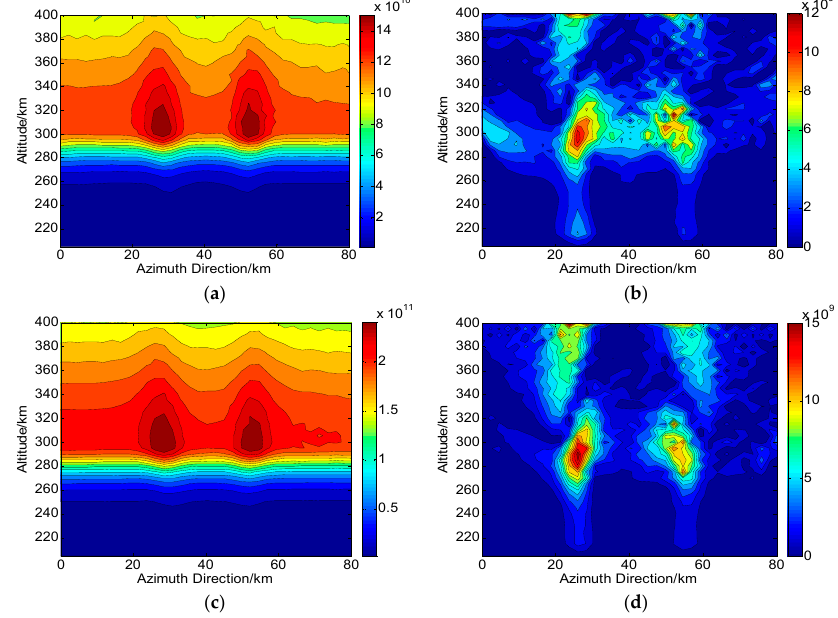
Figure 17. Two-dimensional CIT reconstructions under the condition of joint errors. ( a ) ( Ω C is used) and ( c ) ( Ω BB is used) are the reconstructed results in areas of Changbai and Qingdao, respectively. ( b , d ) are the corresponding absolute deviations between the true and reconstructed results. The unit of the electron density is electrons · m − 3